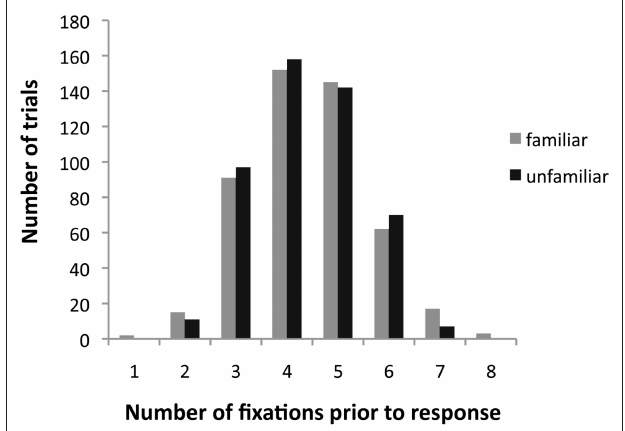
Figure 3 | Distribution of the number of fixations required per trial for familiar/unfamiliar decisions.